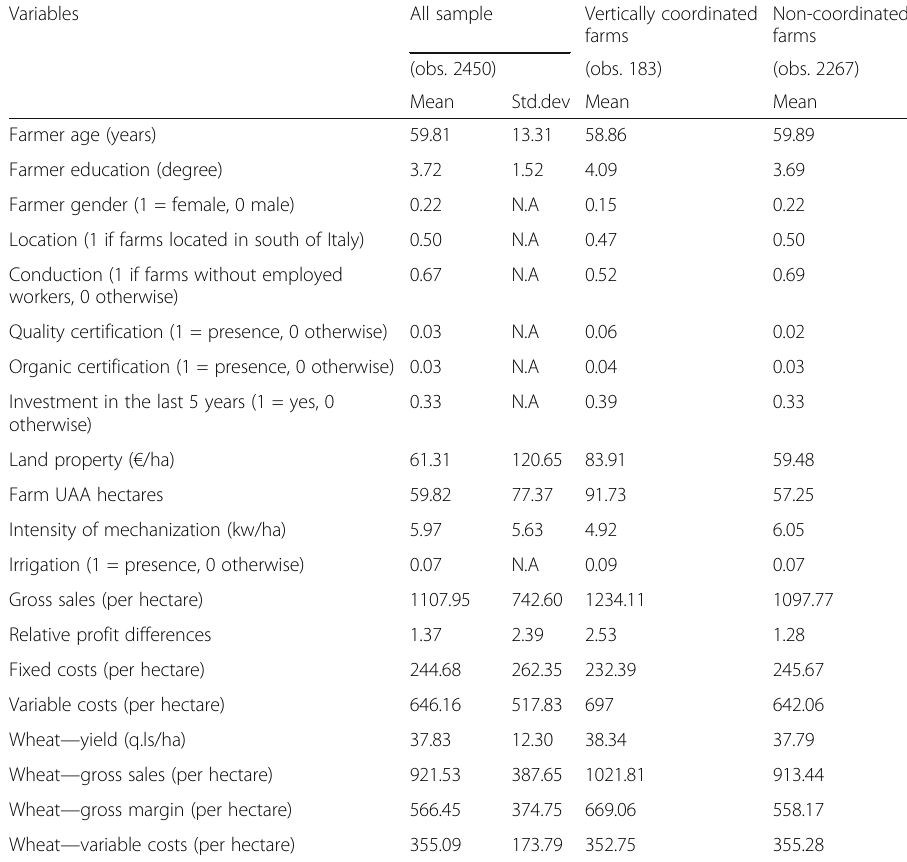
Table 1 Descriptive statistics of variables for coordinated and non-coordinated farms Variables All sample Vertically coordinated